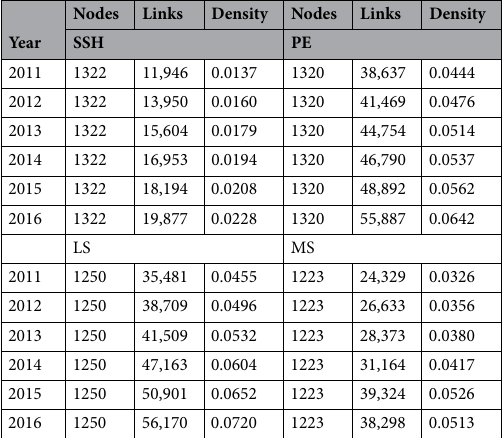
New nodes % new links from new